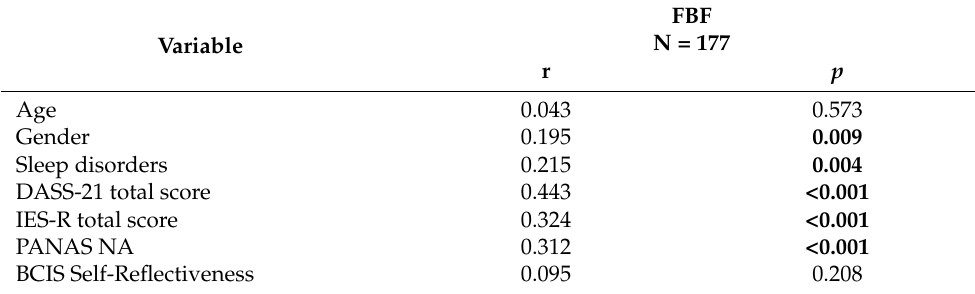
Table 2. Demographic and neuropsychiatric correlates of FBF severity.